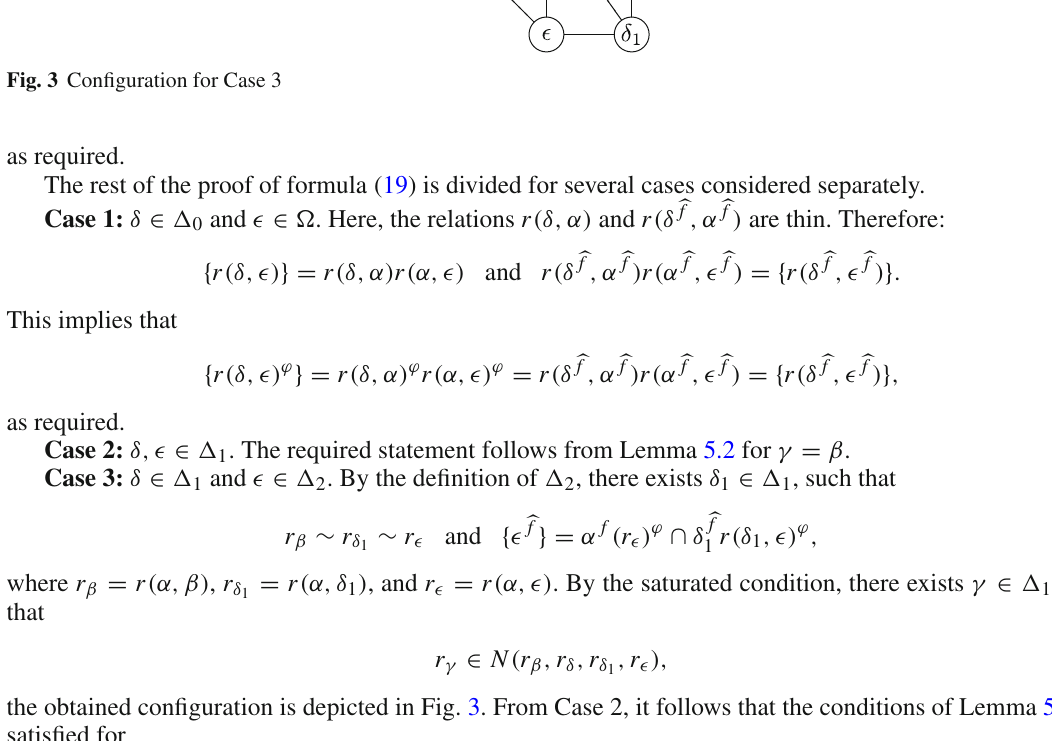
Fig. 3 Configuration for Case 3 as